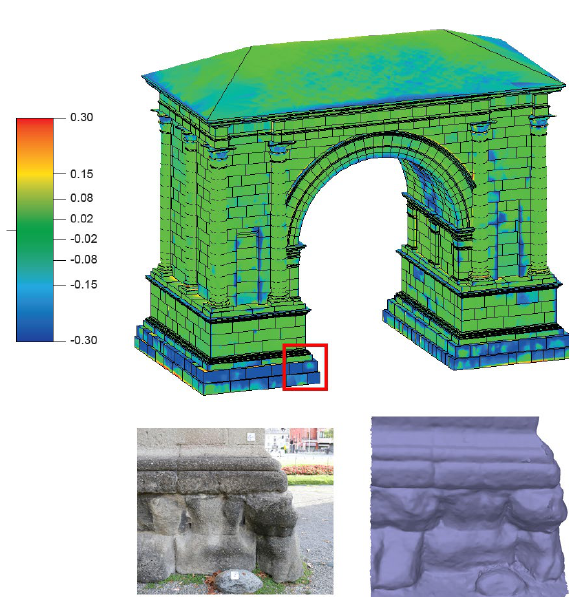
Figure 6: (top) Comparison between the survey model and the conceptual one. The biggest differences are represented in blue. The red box (bottom) localizes the basement of the arch where the effects of decay are evident. They can be recognized in the picture (on the left) or in the mesh model (on the